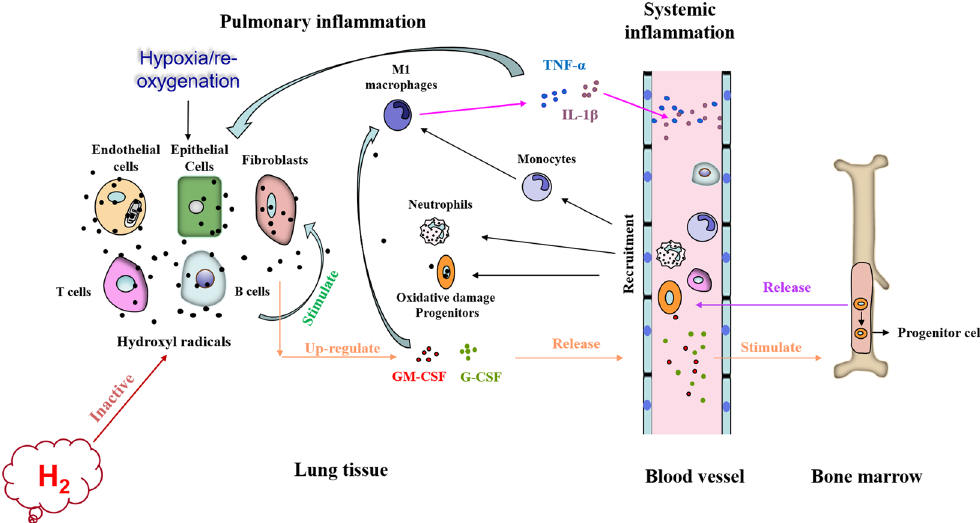
Figure 8. Mechanisms by which inhaled H 2 may alleviate H/R-induced lung injury. H/R increases hydroxyl radicals, which may activate various cell types, such as epithelial cells, fibroblasts, T cells, B cells, neutrophils and macrophages. The net result is up-regulation of colony-stimulating factors, which stimulate the release of leukocytes and progenitors from bone marrow, which migrate into inflamed lung tissue. In lung tissue, infiltrated leukocytes and monocytes follow M1 polarization and release proinflammatory factors, which increase the secretion of colony-stimulating factors. The ability of infiltrated progenitors to repair lung tissue is compromised. H 2 inactivates hydroxyl radicals induced by H/R, which down-regulates colony-stimulating factors, thereby inhibiting release of leukocytes from bone marrow and their infiltration into lung tissues. The repair ability of progenitors may also